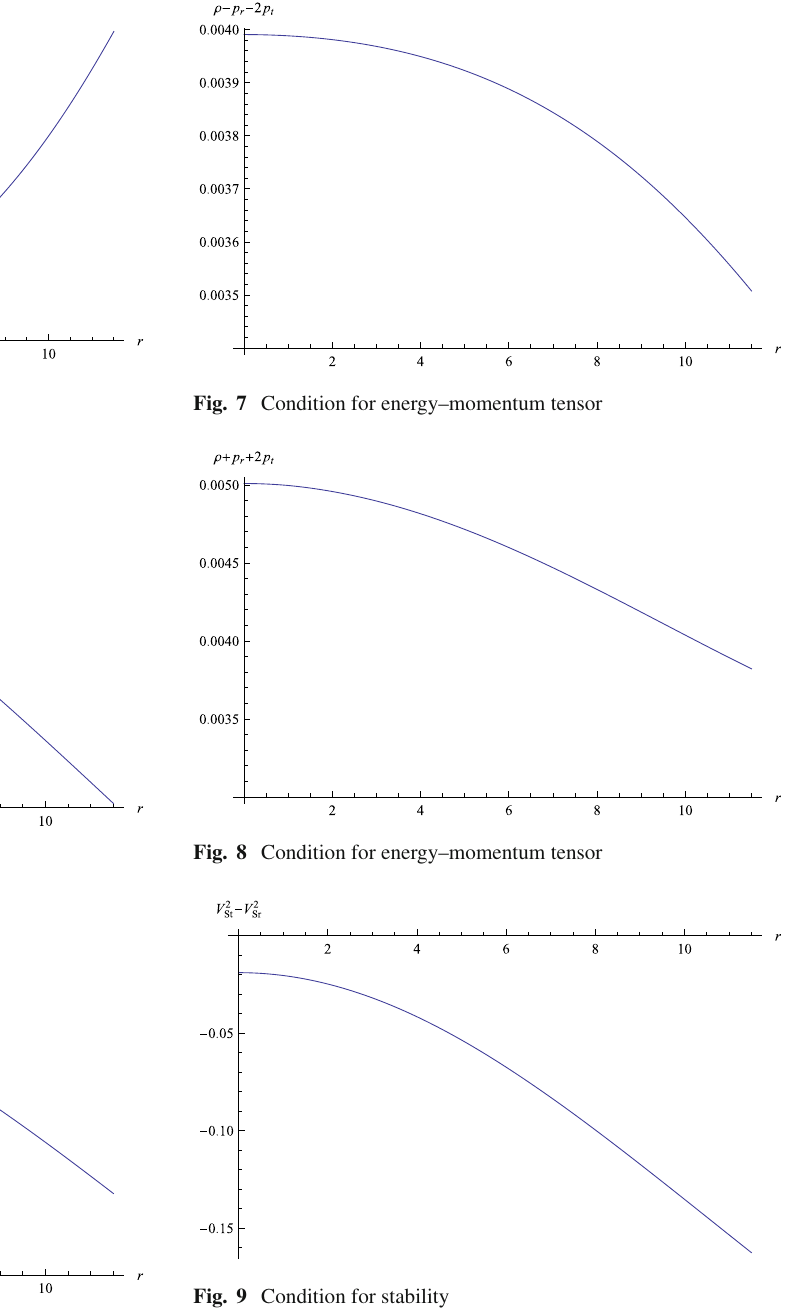
Fig. 6 The square of tangential speed of light